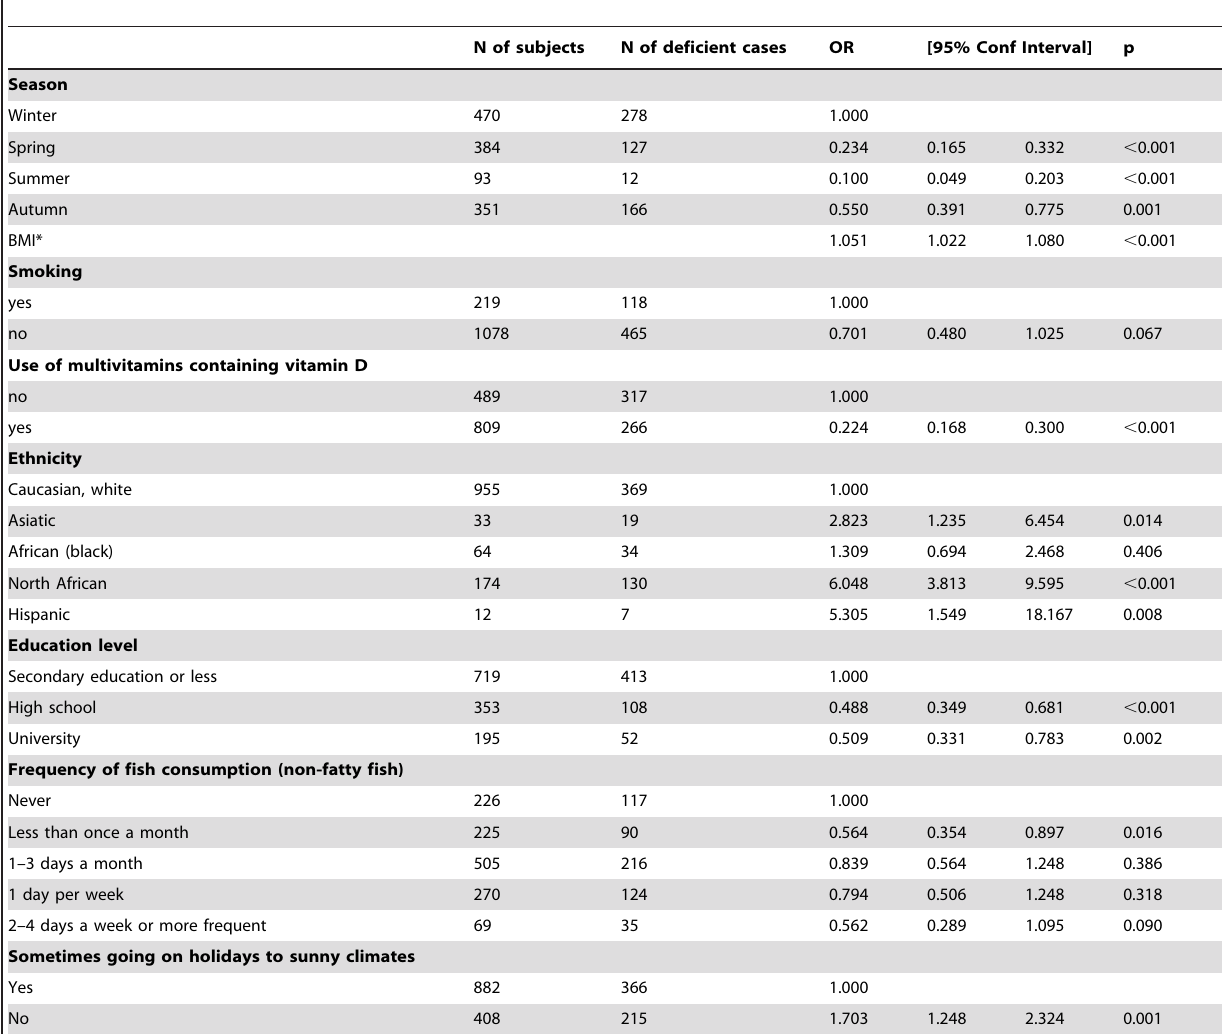
Table 4. Risk of vitamin D deficiency during pregnancy in Belgium (25-(OH)D , 20 ng/ml) (n= 1100), results of multiple logistic regressions.